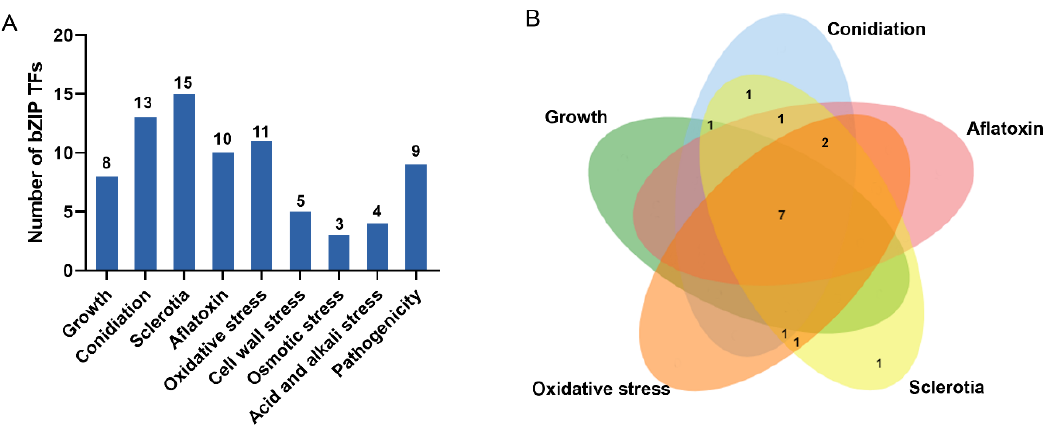
Figure 3. Phenotypic analysis of 15 bZIP transcription factor mutants in different biological processes of Aspergillus flavus . ( A ) Number of bZIPs that display mutant phenotypes in different biological processes. ( B ) A Venn diagram that depicts the number of mutant phenotypes. The phenotypes included developmental characteristics (mycelial growth, conidiation, and sclerotial production), aflatoxin and oxidative stress. Table 1. Phenotypic summary of 15 bZIP transcription factor gene-deleted mutants Oxidative Cell Wall Osmotic Acid and Al- Mutant Growth Conidiation Sclerotia Aflatoxin Stress Stress Stress kali Stress Reduced